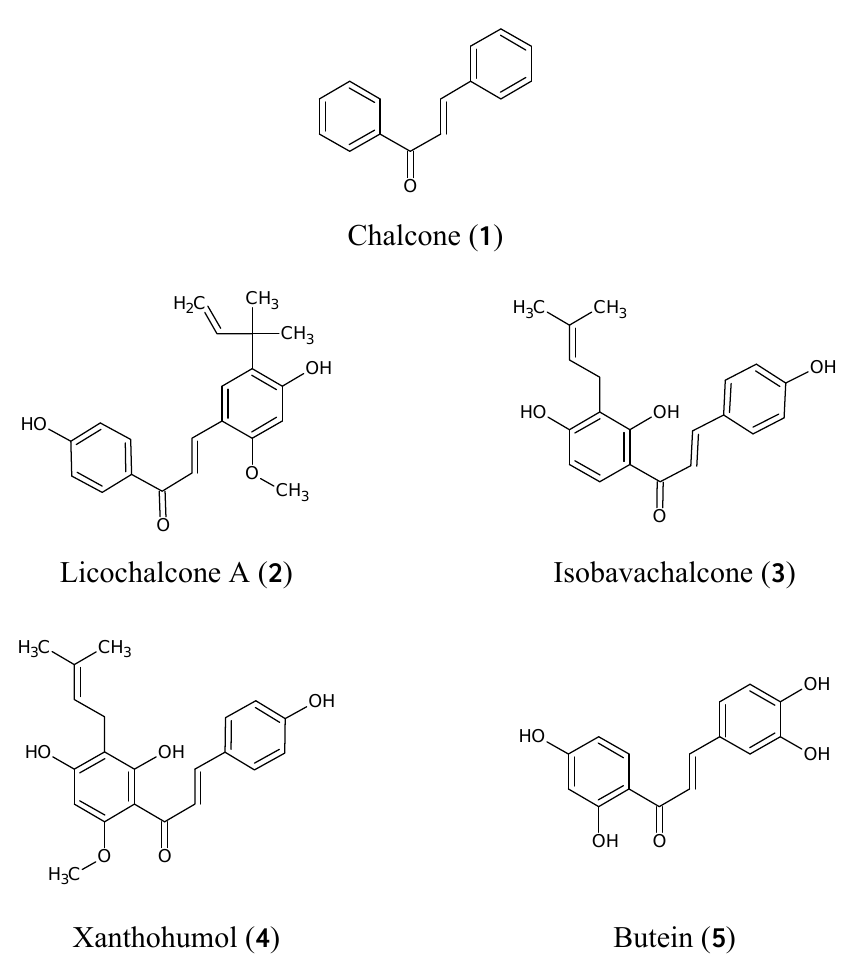
Figure 1. Chemical structures of the studied